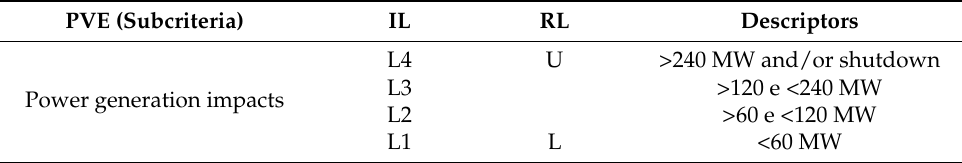
Table 3. Example of descriptors with impact and reference